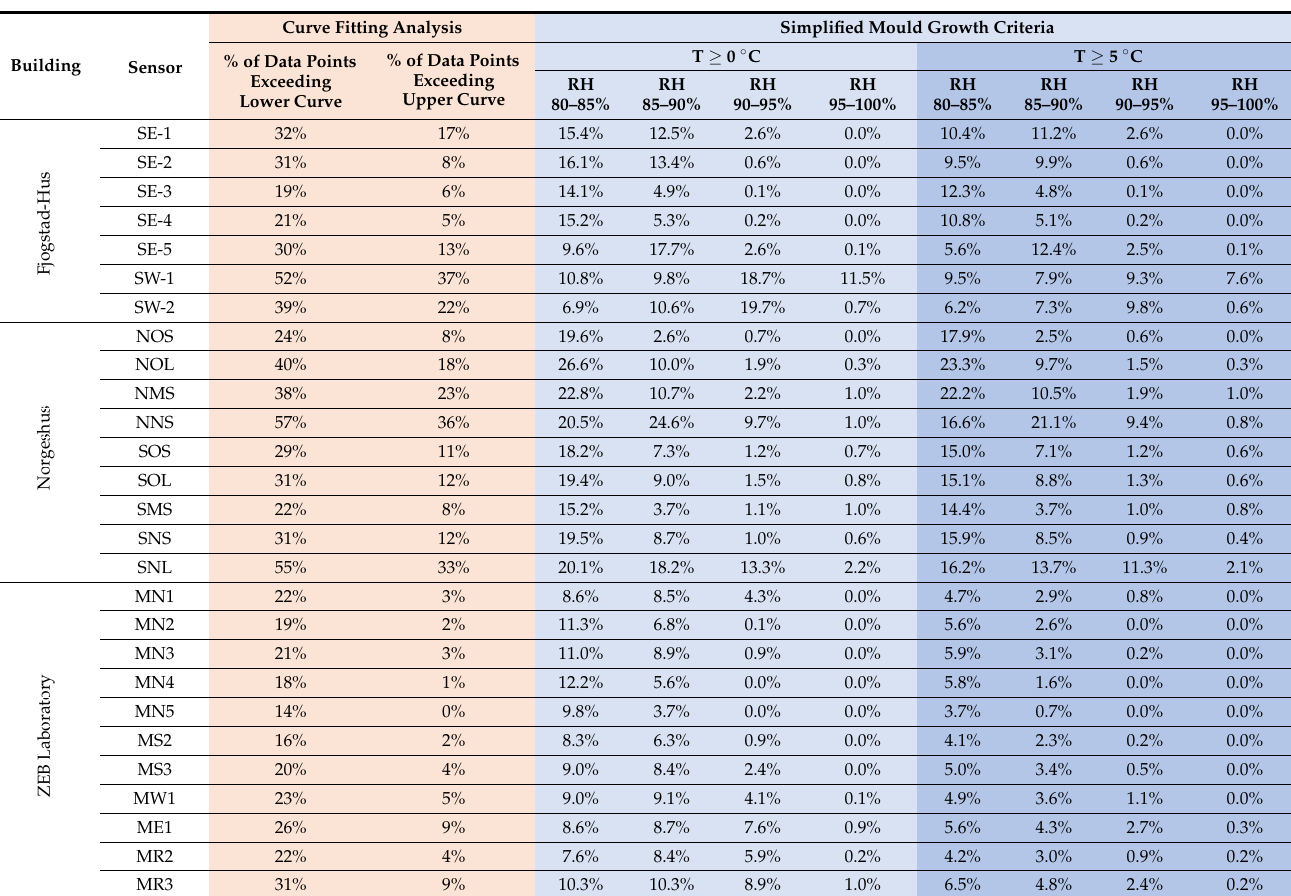
Table 5. Results of the curve fitting analysis and the simplified mould growth criteria analysis. The analyses are separated by colour for legibility.